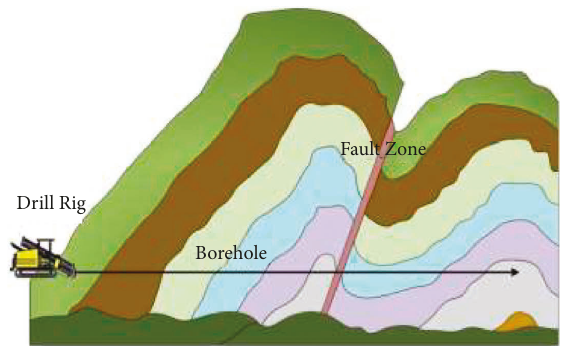
Figure 1: Schematic diagram showing horizontal directional drilling and tunneling for a geological